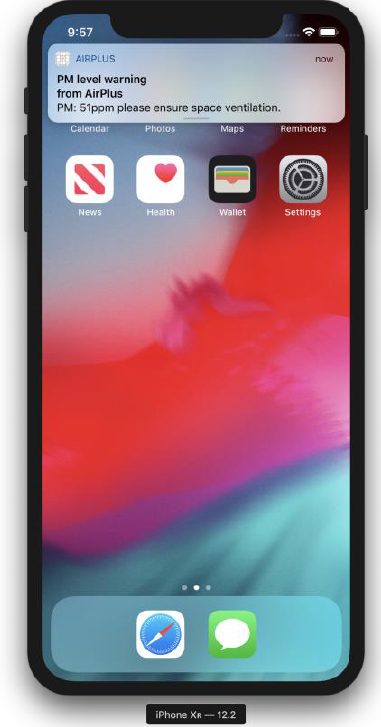
Figure 10. AirPlusWeb: notification feature.